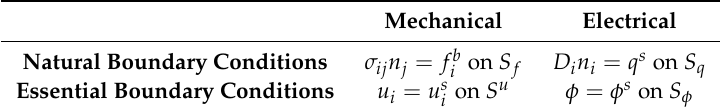
Table 1. Boundary conditions for the dynamic piezoelectric